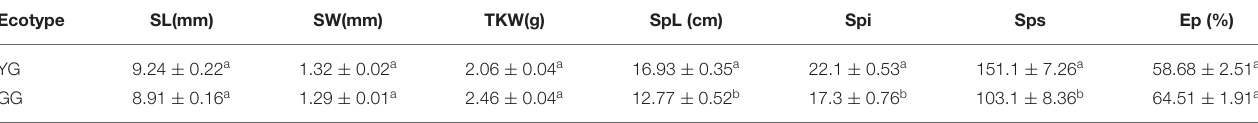
TABLE 1 | Seed traits of different ecotypes of L. chinensis . Ecotype